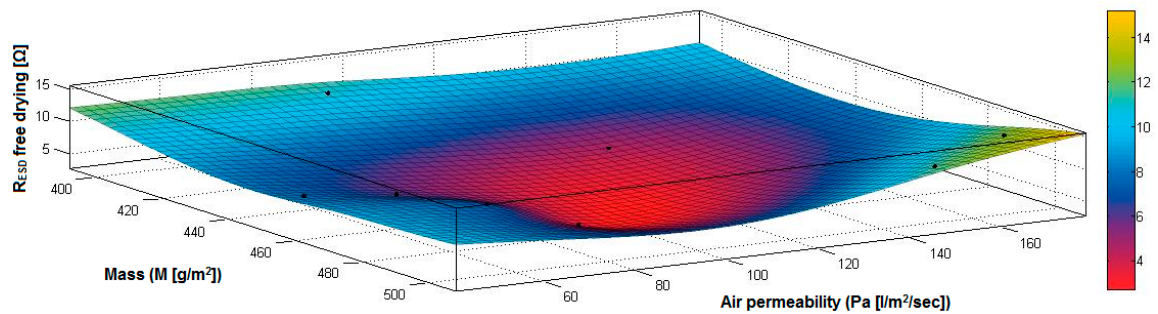
Figure 24. 3D representation R ESD free drying = f(M, Pv) for samples preliminarily treated in RF plasma O 2 using RF 1 generator and power 200 W.